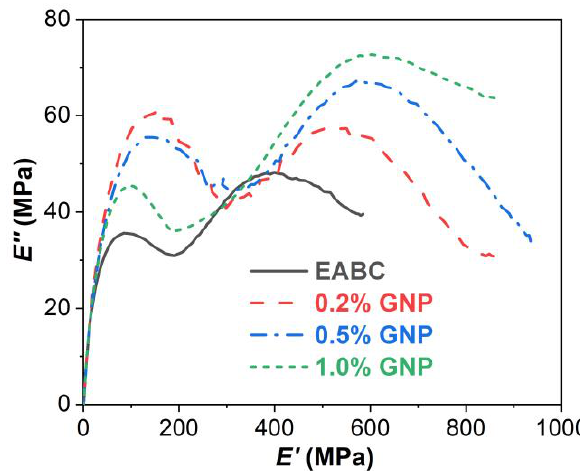
Figure 9. Cole – Cole plots of GNP-reinforced EABCs. Figure 9. Cole–Cole plots of GNP-reinforced